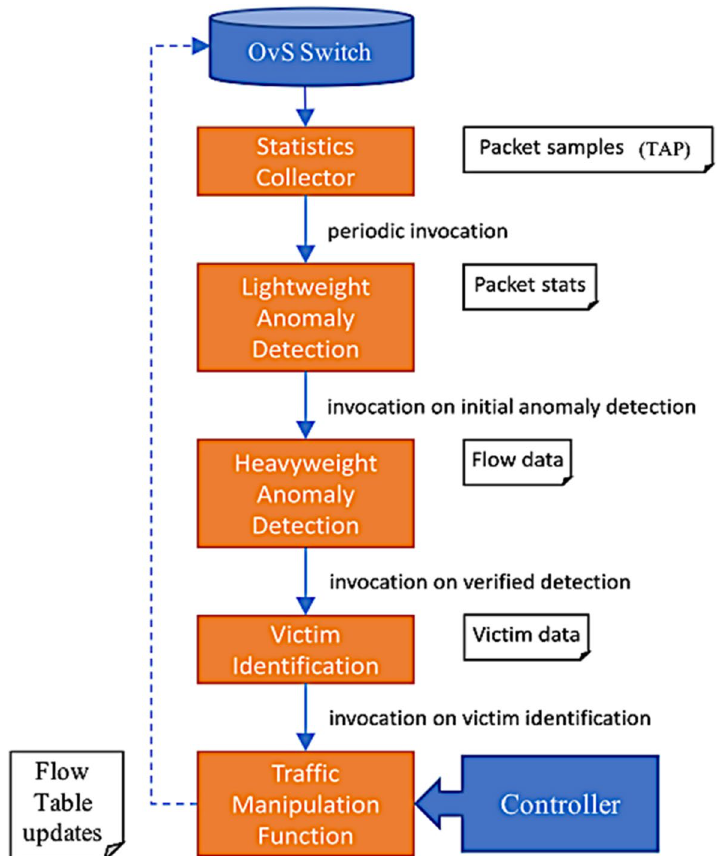
Fig. 13 High-level workflow of network anomaly